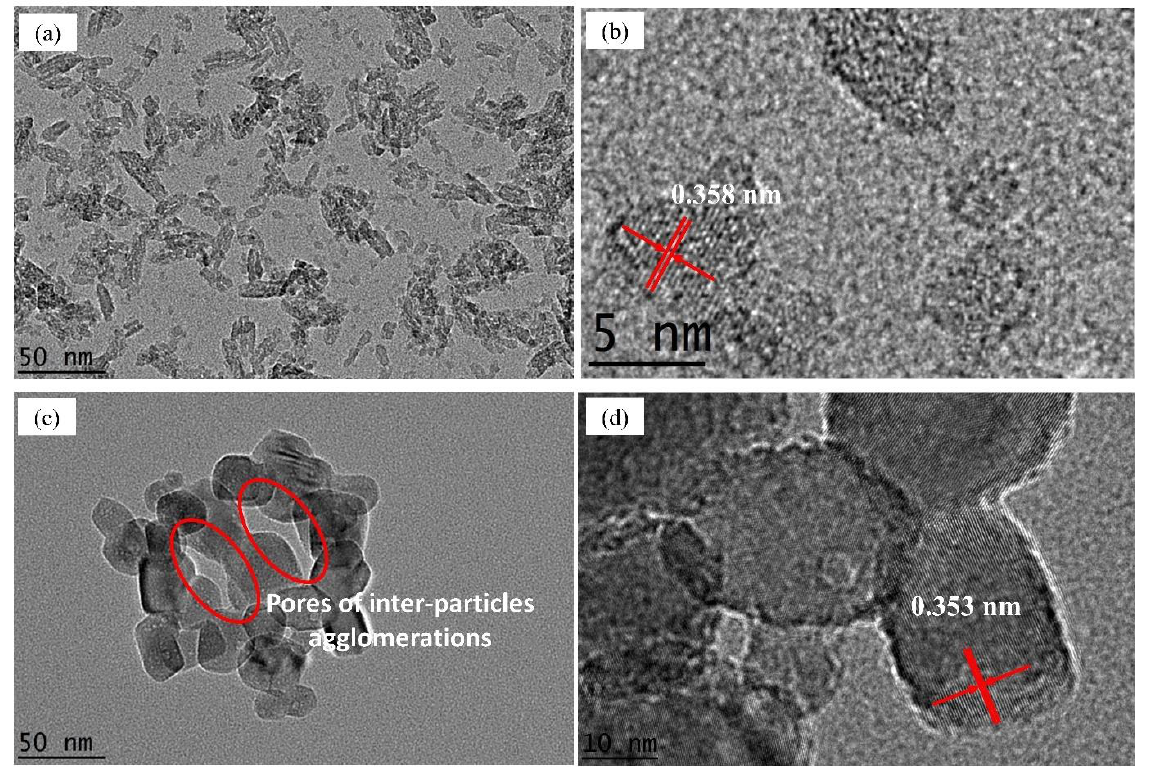
Figure 2. HRTEM images of the synthesized QD TiO 2 at ( a ) 88 KX and ( b ) 530 KX, and commercial TiO 2 nanoparticles at ( c ) 88 KX and ( d ) 360 KX.